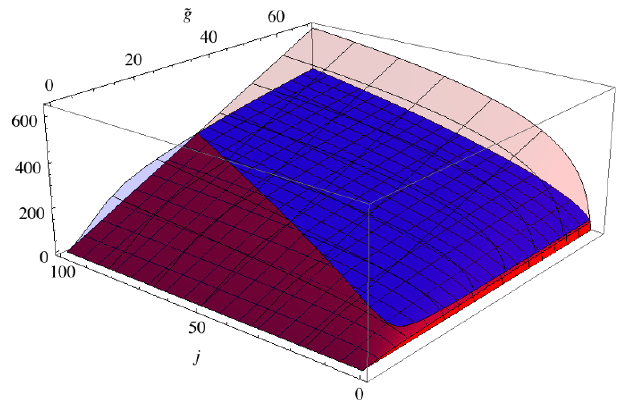
Figure 4. F large (red solid and transparent surface) and F small (blue solid and transparent surface) plotted together in the ~ g (cid:0) j plane. Dominant branches are in transparent colour while subdominant ones are in solid colour. The transition line between them is clearly